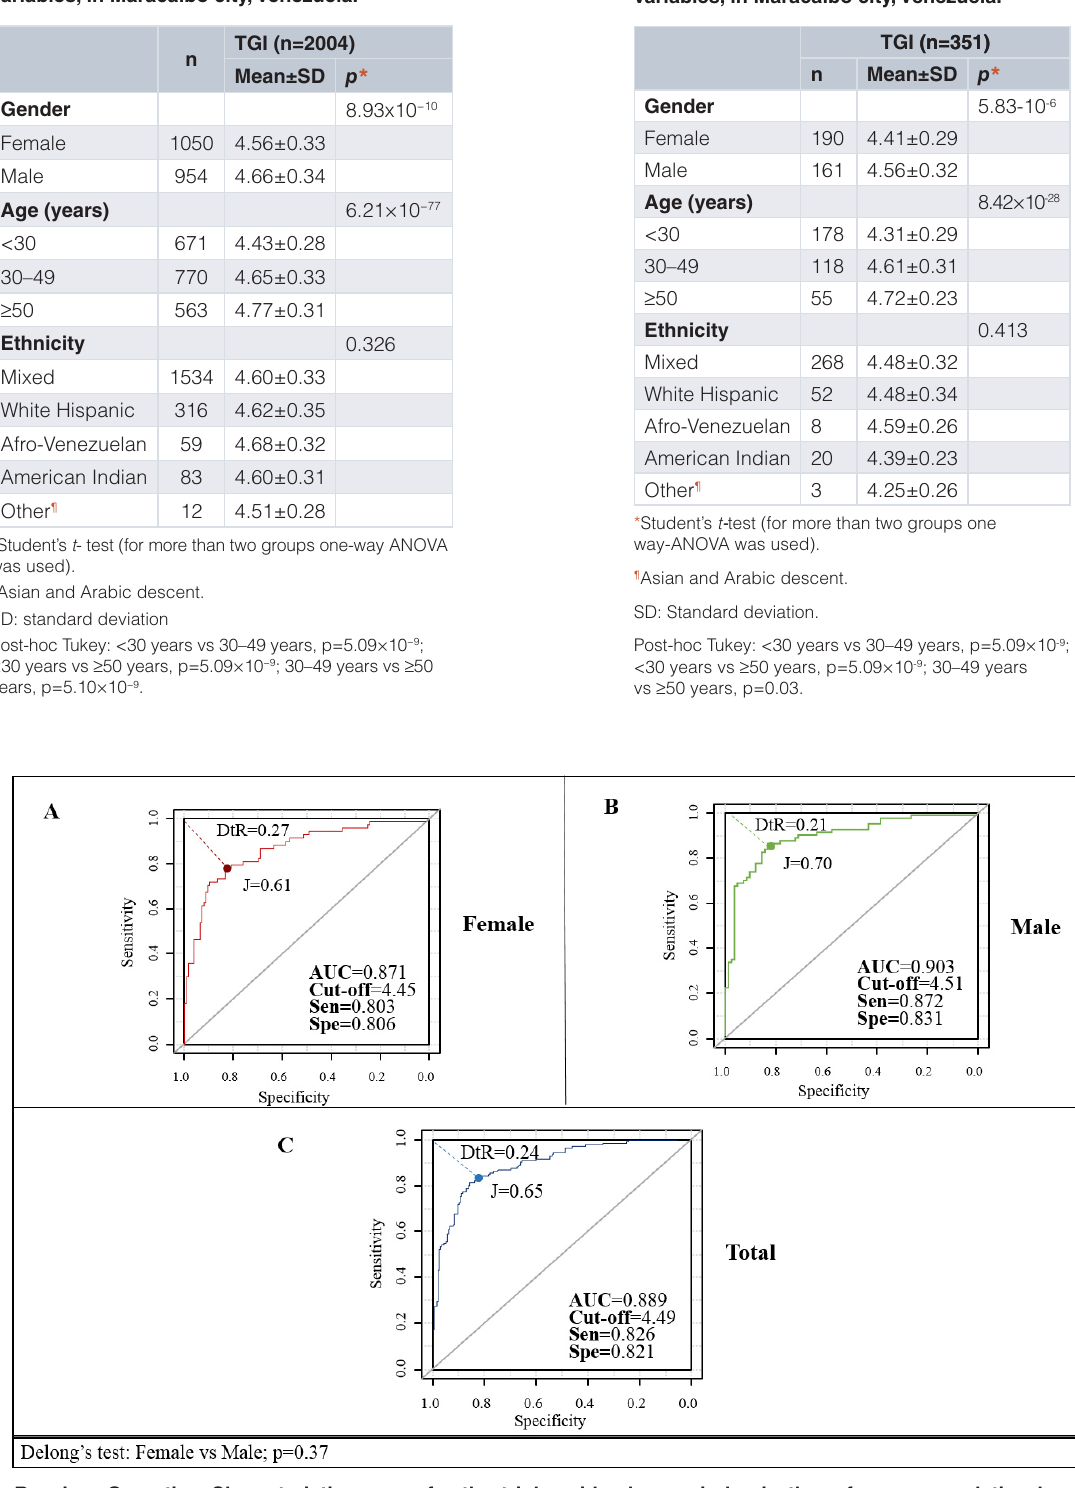
Figure 2. Receiver Operating Characteristic curves for the triglyceride-glucose index in the reference population by gender, in Maracaibo city, Venezuela. DtR, Distance to ROC; J, Youden Index; AUC, are under the curve; sen, sensitivity; spe,